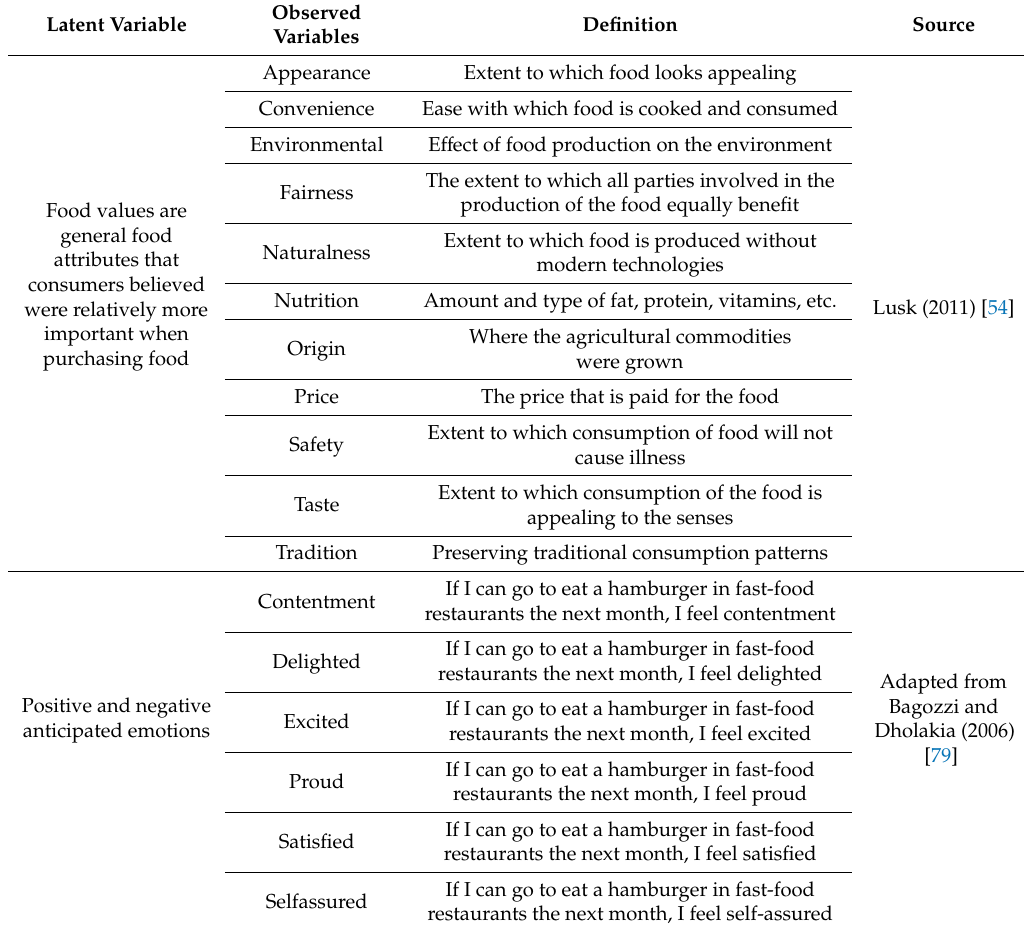
Table 2. Questionnaire